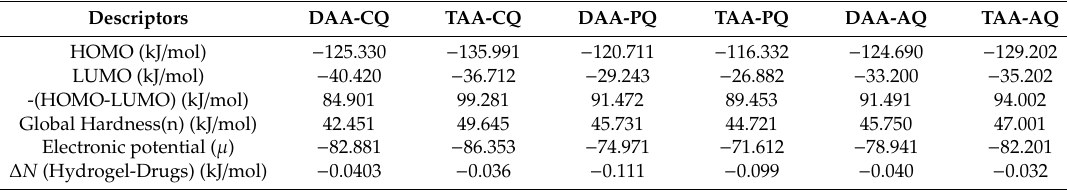
Table 3. Molecular descriptors from frontier orbitals, for the complex drugs-hydrogel model at wb97xd / 6-31 ++ G(d,p).